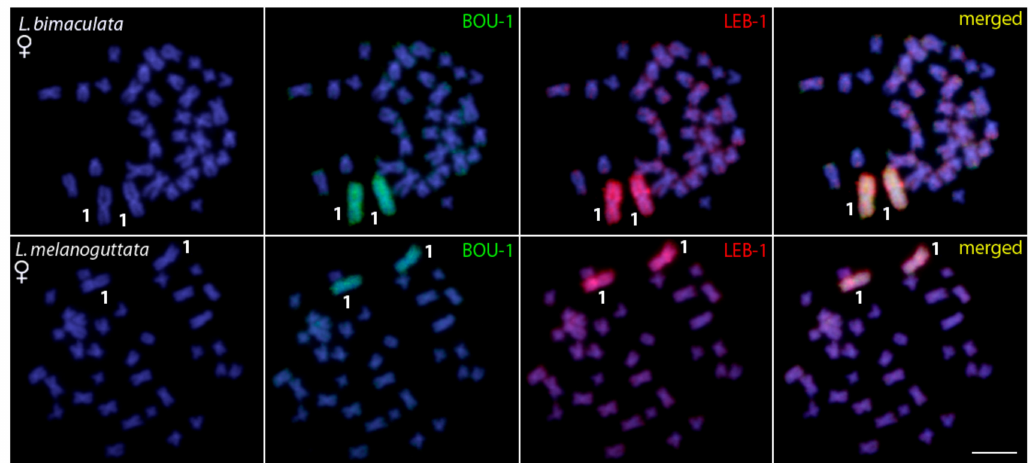
Figure 6. WCP with the LEB-1 (red) and BOU-1 (green) probes derived from pair 1 of Lebiasina bimaculata and Boulengerella lateristriga , respectively, hybridized against female metaphase chromosomes of Lebiasina bimaculata and Lebiasina melanoguttata . No di ff erences between the sexes were observed. Bar = 5 µ